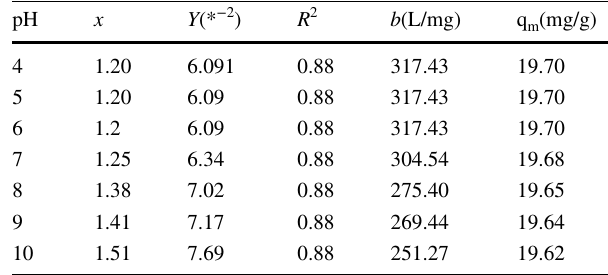
Table 6 Langmuir parameters for mercury adsorbed by powdered